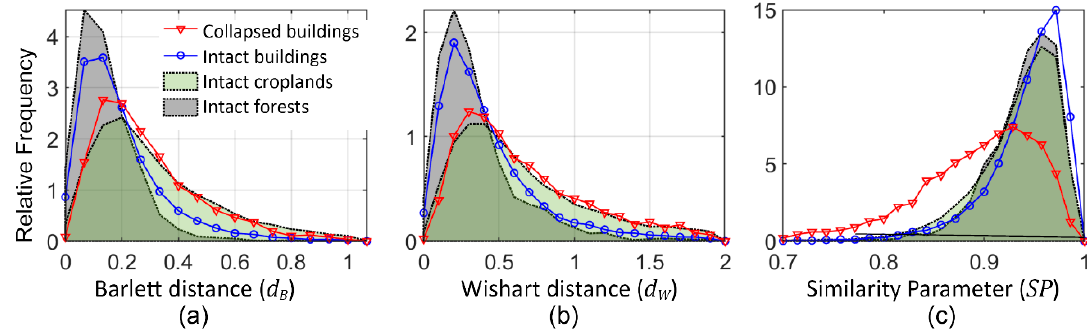
Figure 5. Histograms of matrix dissimilarity measures: ( a ) the Bartlett distance ( 𝑑 (cid:3003) ), ( b ) the revised Wishart distance ( 𝑑 (cid:3024) ), and ( c ) the polarimetric similarity parameter.